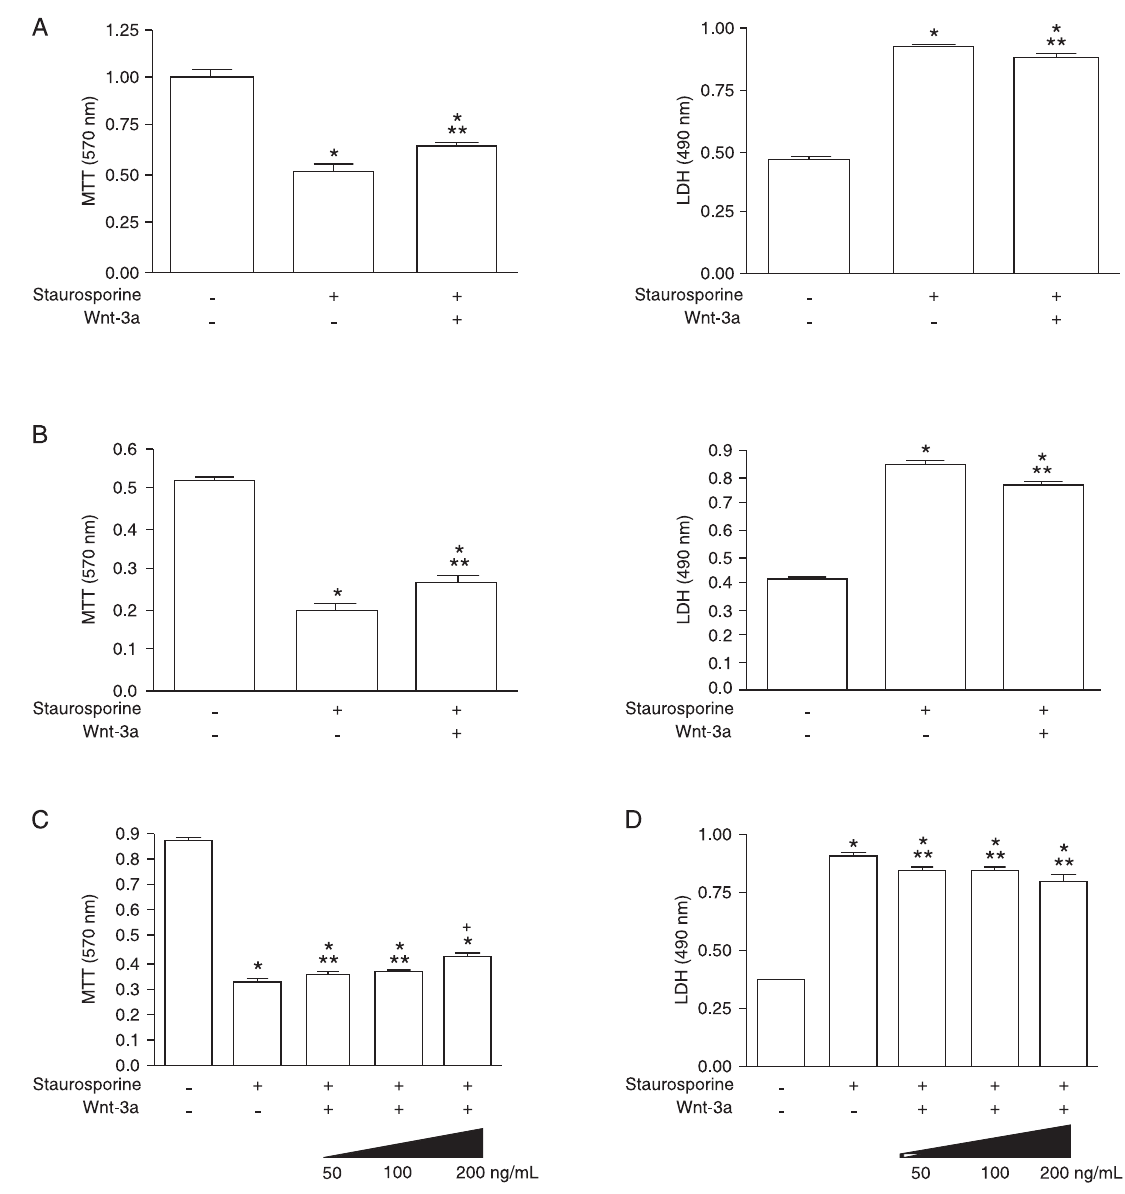
Figure 3. Wnt-3a peptide reduced the loss of cell viability induced by staurosporine. A , B , PC12 cells were incubated with 100 nM ( A ) and 500 nM ( B ) staurosporine 24 h after the addition of mouse recombinant Wnt-3a peptide (100 ng/mL). C , D , PC12 cells were incu- bated with 500 nM staurosporine 24 h after the addition of three different concentrations of mouse recombinant Wnt-3a peptide (50, 100, and 200 ng/mL). Twenty-four hours later, cell viability was measured by MTT and lactate dehydrogenase (LDH). Data are reported as means ± SEM for 6 independent experiments. *P <0.001 vs control (vehicle: 0.08% DMSO); **P < 0.05 vs staurosporine; + P < 0.05 vs staurosporine + 50 ng/mL Wnt or staurosporine + 100 ng/mL WNT (one-way ANOVA followed by the Newman-Keuls